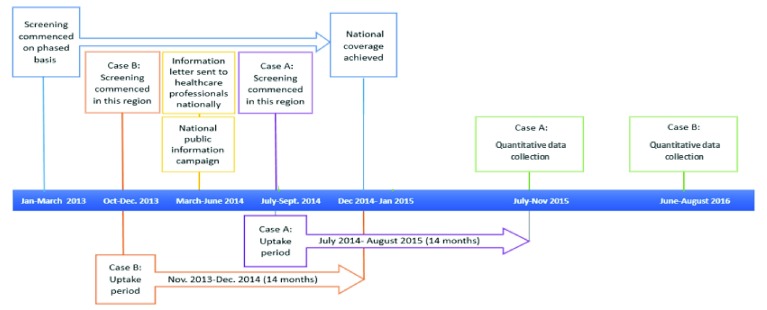
Timeline of the national programme, RetinaScreen, and data collection at study sites.